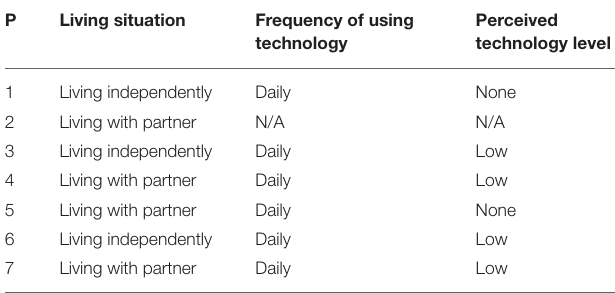
TABLE 1 | Background information of our seven participants